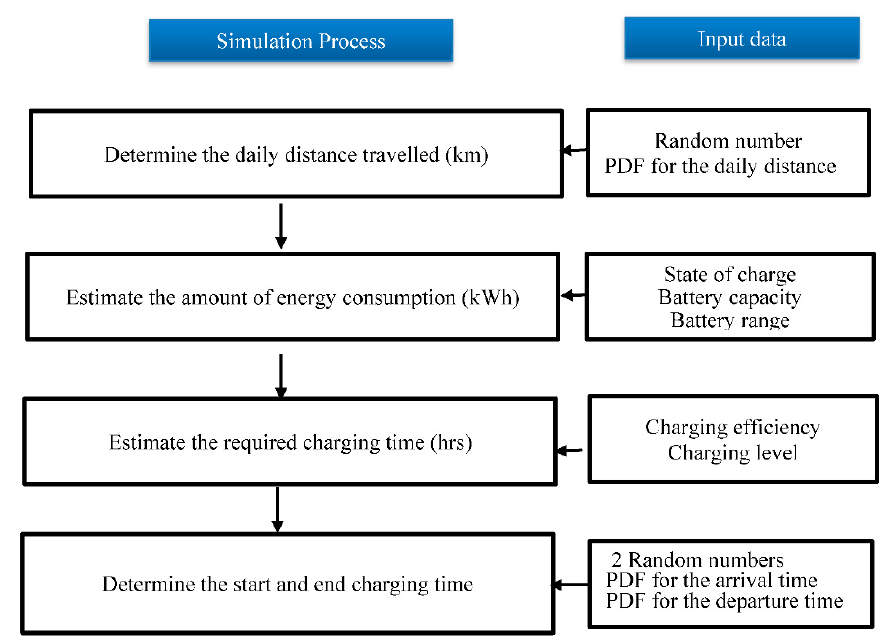
Figure 5. The simulation process for developing the EV charging